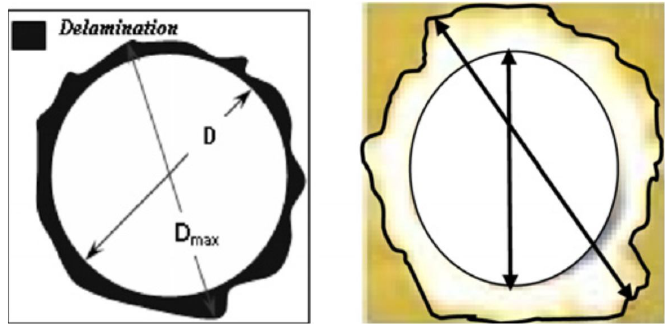
Fig. 3. Schematic diagram of delamination factor